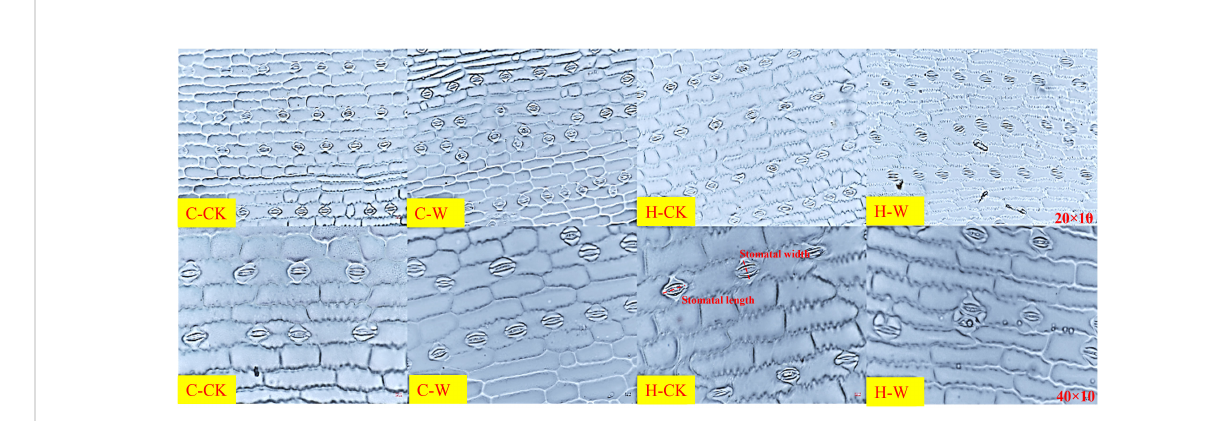
consistent (Figure 4). The stomatal limitation (Ls) of summer maize increased signi fi cantly after waterlogging stress, and H 2 O 2 priming could signi fi cantly reduce the Ls of waterlogged maize. In 2020, the stomatal limitation of H-W decreased by 15.7% compared with C-W. The two-year results were basically